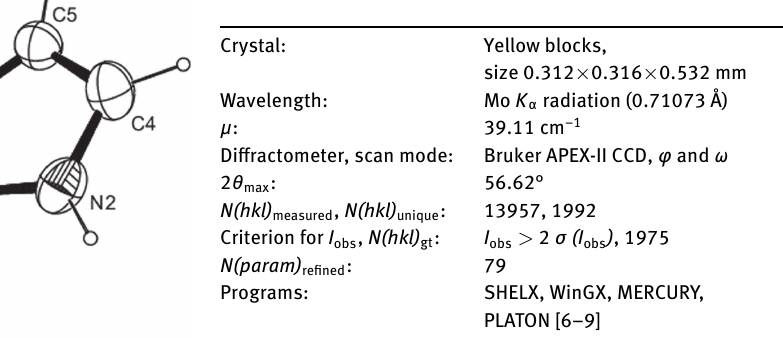
Table 1: Data collection and handling.